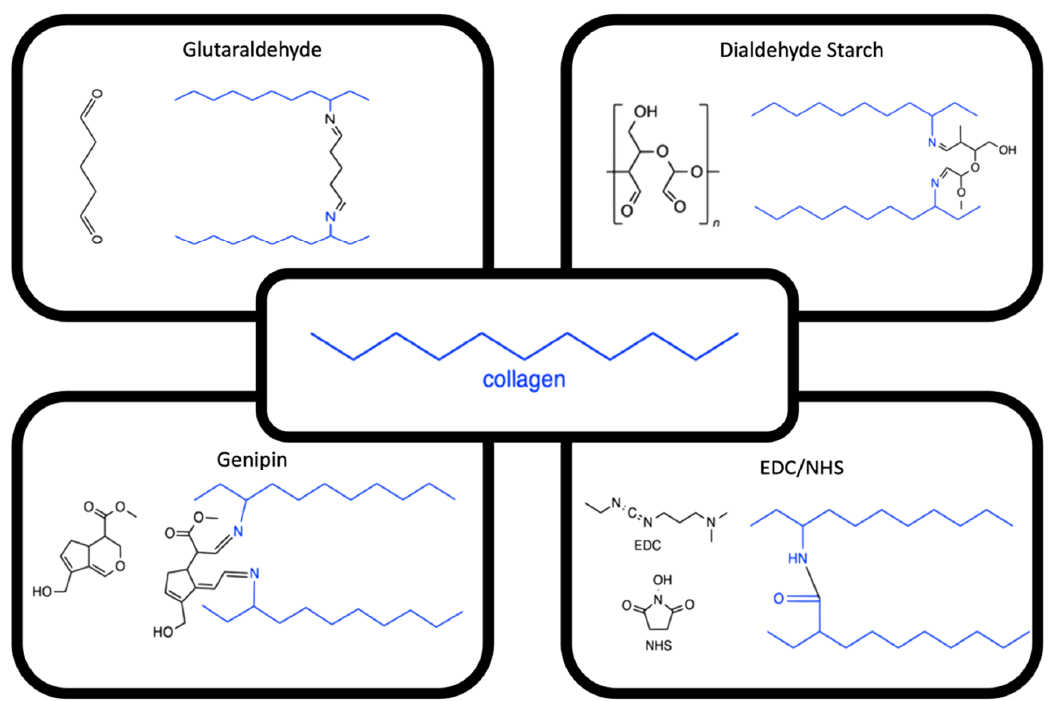
Figure 2. Collagen chemical crosslinker mechanisms glutaraldehyde, dialdehyde starch, genipin, and EDC/NHS [37,41,46,47].